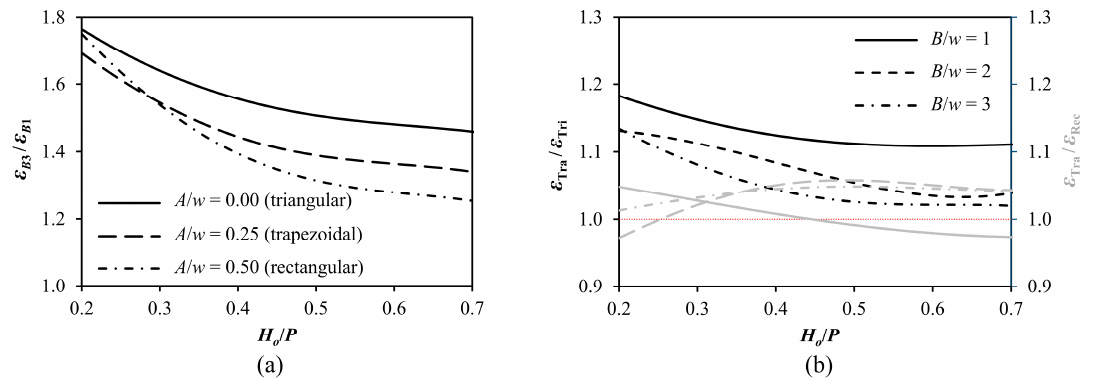
Figure 20. Efficiency curves.